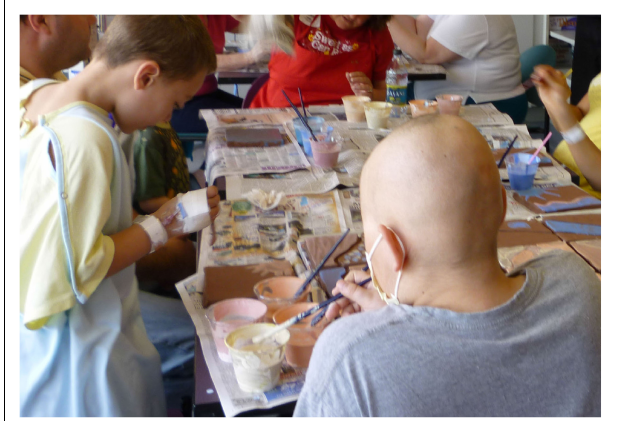
FIGURE 5 | Children’s hospital art